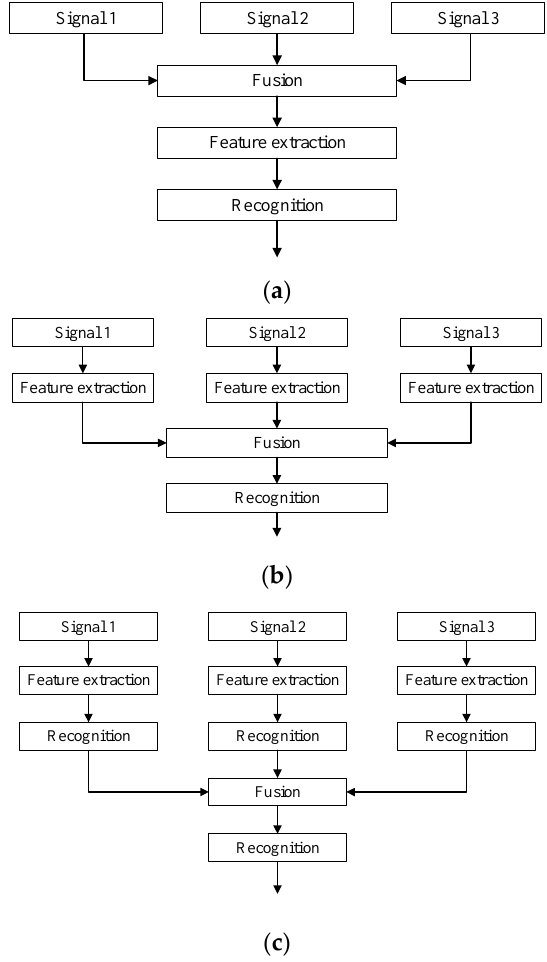
Figure 1. Three kinds of fusion structure. ( a ) Data Level Fusion; ( b ) Feature Level Fusion; ( c ) Decision Level Fusion.